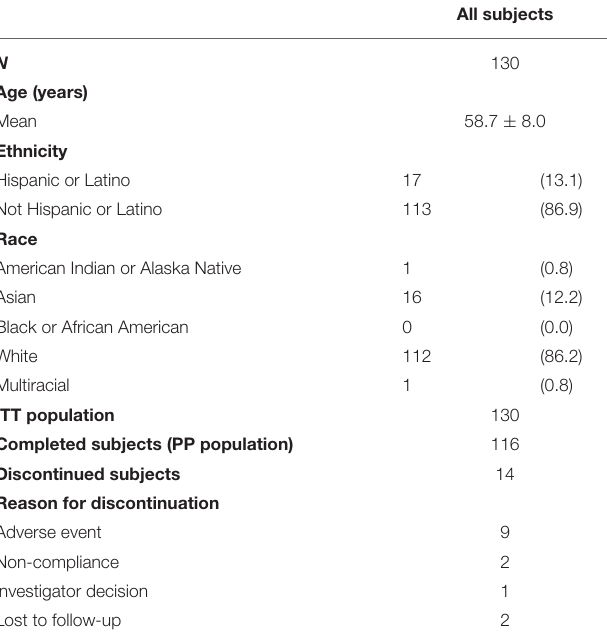
TABLE 3 | Demographic information on clinical trial #2.